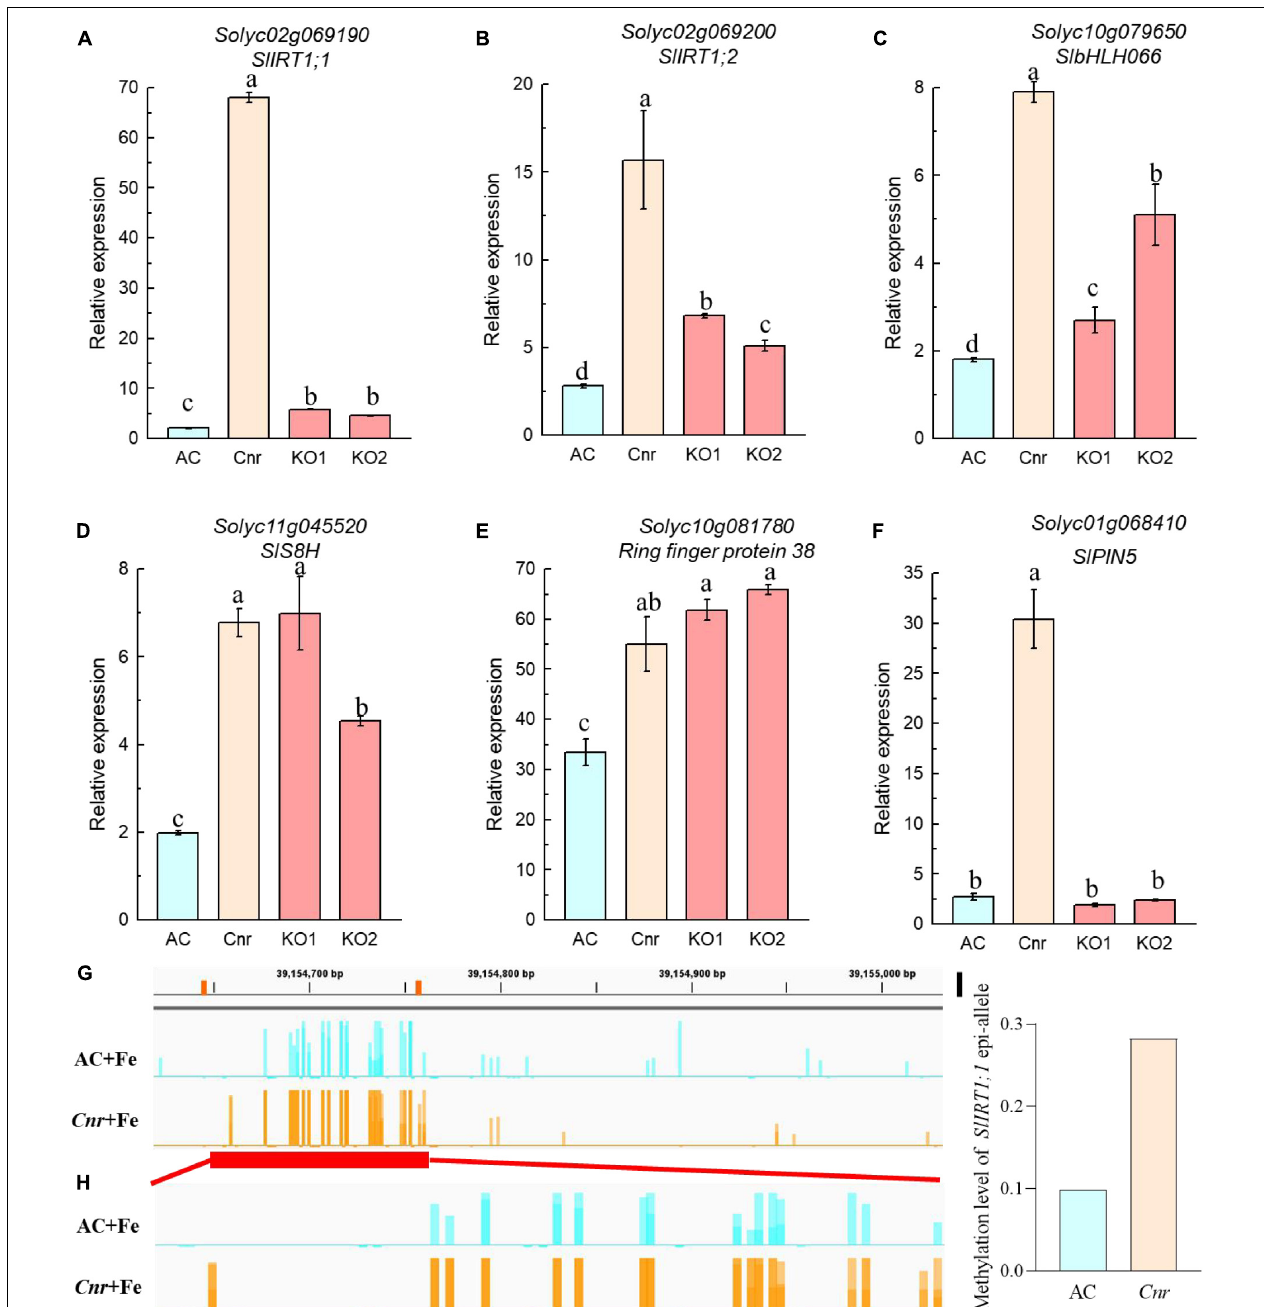
FIGURE 3 | Expression analysis of Cnr -mediated Fe-deficiency-responsive genes by RT-qPCR. (A–F) Roots of AC, Cnr , and two SlSPL-CNR knockout plants (KO1 and KO2) grown in Fe-sufficient solution were harvested for RNA extraction and qRT-PCR analysis. ACTIN was used as an internal control to normalize expression. Data are means ± SD ( n = 3 for biological repeats). Different letters indicate significant differences among AC, Cnr and two KO lines under +Fe treatment by Tukey’s test at P ≤ 0.05 level. (G,H) Targeted bisulfite sequencing reveals changes of DNA methylation at the SlIRT1;1 gene promoter (G) and the 115-bp epi-allele region of SlIRT1;1 promoter (H) in AC and Cnr roots after 3 days under +Fe condition, respectively. (I) The methylation levels of the epi-allele in the promoter region of SlIRT1;1 as shown in panel (H)